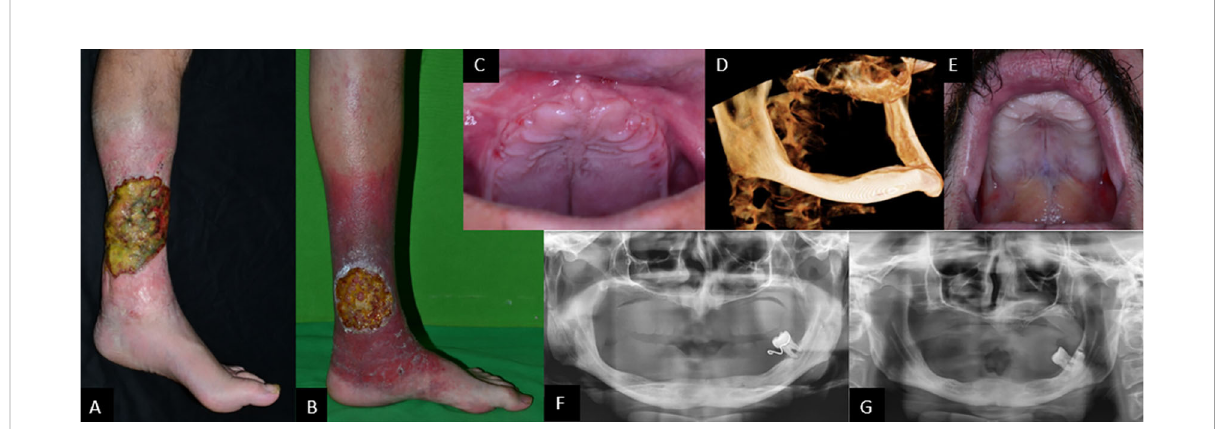
FIGURE 1 Bio fi lm-covered, 14-×-18-cm large ulcer in P1 (A) and 10-cm-diameter ulcer in P2 (B) , both on left leg. Complete tooth loss in P1 (C) and P2 (E) . Cone-beam CT scan showing severely atrophied jaws and missing processus alveolaris (D) . Panoramic radiographs showing highly atrophied jaws and a single remaining erupted tooth in both patients: P1 (F) and P2 (G)